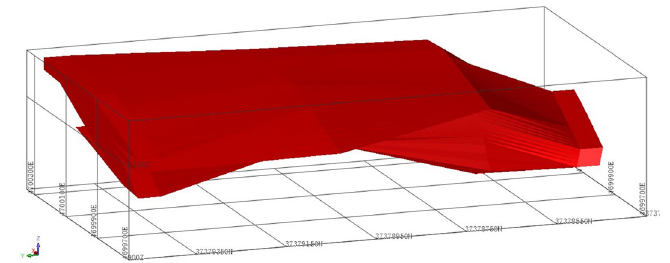
Figure 1. 3D model of ore body.